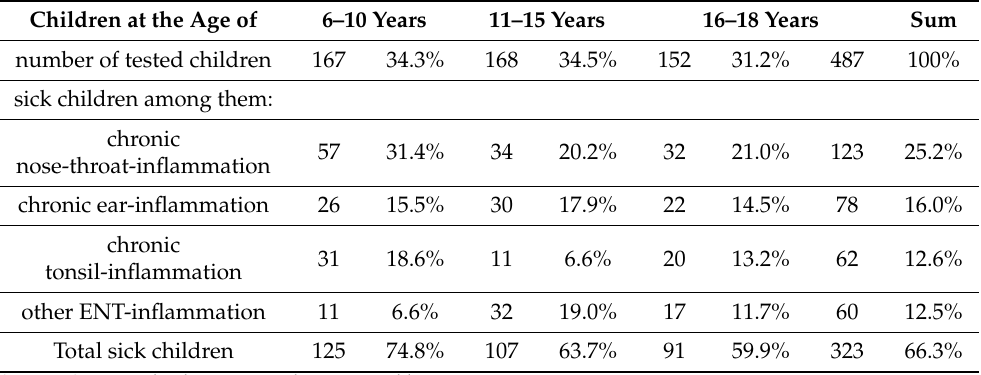
Table 4. ENT diseases of children from Sovkhoz School “Engels”, Rayon Kazalinsk, District